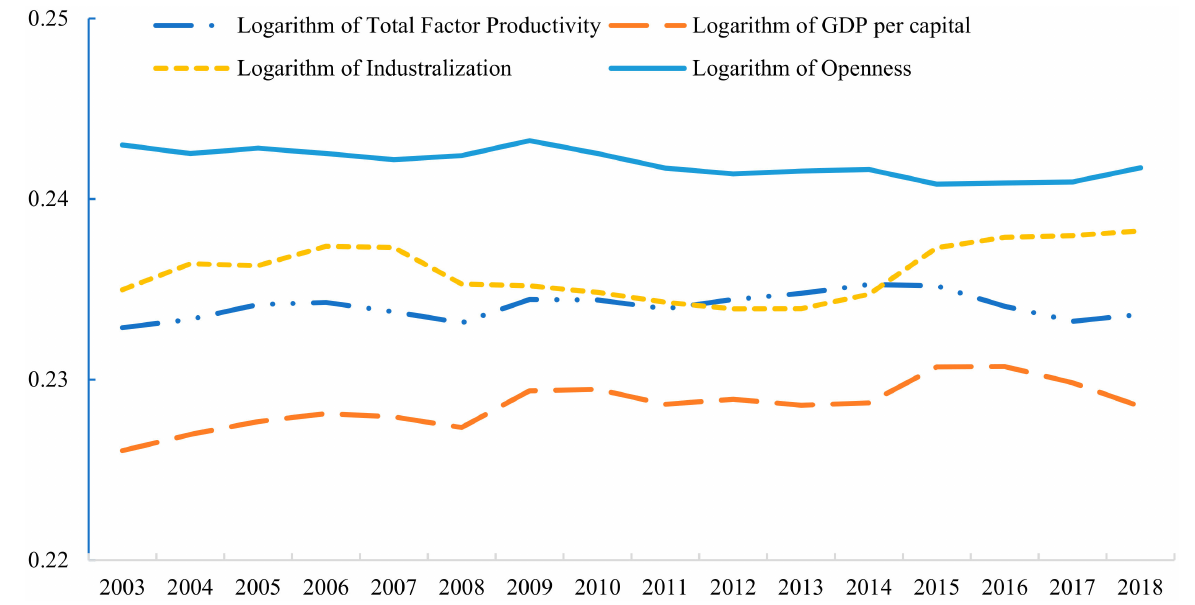
Figure 6. Temporal change in the coefficient of elasticity in Belt and Road